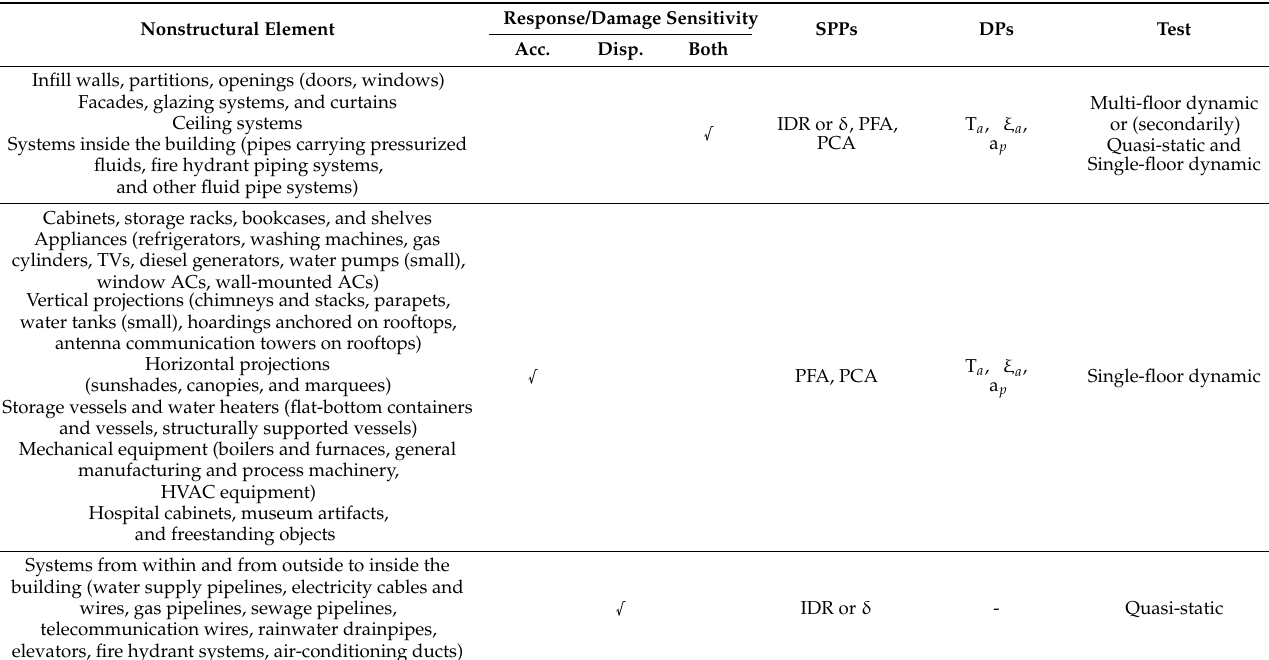
Table 1. Recommended test protocol and DPs and SPPs required for the tested